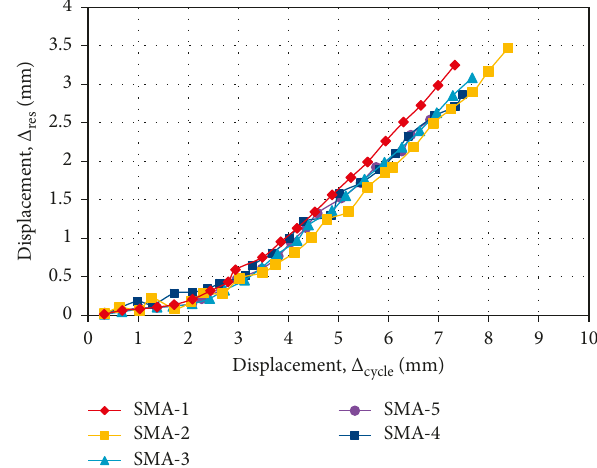
Figure 18: Comparison for loading forces along the measurement displacement loading cycles (SMA material model series).